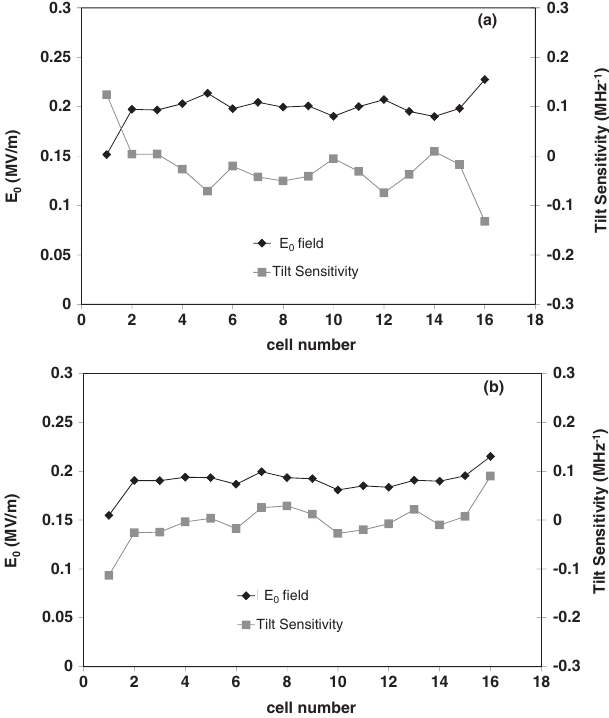
FIG. 31. PCs are adjusted, taking into account the increasing length of the cells for 5 PCs (a) and 7 PCs (b).